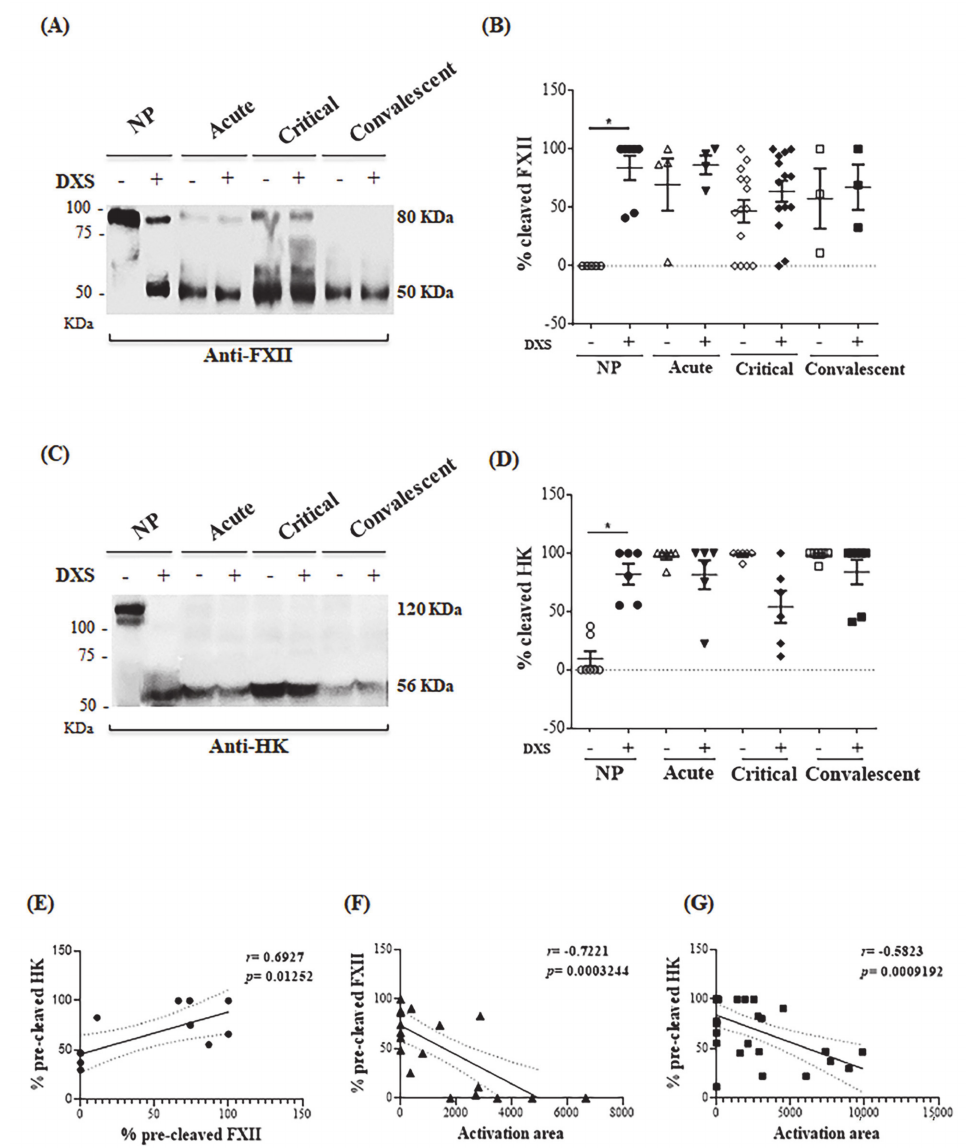
Figure 7. Evidence of early consumption of FXII and HK in the plasmas obtained from DENV-positive patients. NP or DP, at different stages of infection, were incubated or not with DXS for 1 h, at 37 ◦ C. The presence of FXII and HK were evaluated by western blotting. The bands corresponding to intact and cleaved proteins were measured using ImageJ software and the percentage of cleaved proteins was calculated. ( A ) Representative western blotting of FXII levels in plasmas collected from a single patient, at different time points of infection; ( B ) Individual plots of the percentage of cleaved FXII from plasmas incubated or not with DXS; ( C ) Representative western blotting of HK levels in plasmas collected from a single patient, at different time points of infection. ( D ) Individual plots of the percentage of cleaved HK from plasmas. * indicates p ≤ 0.05. ( E ) Correlation graph and calculation between the frequency of cleaved FXII and cleaved HK, in the absence of DXS (pre-cleaved), as measured by western blotting. ( F ) Correlation graph and calculation between PKa activation, as measured by the hydrolysis assay (activation area) with the frequency of cleaved FXII, in the absence of DXS (%pre-cleaved FXII), measured by western blotting; ( G ) Correlation graph and calculation between PKa activation, as measured by the hydrolysis assay (activation area) with the frequency of cleaved HK, in the absence of DXS (%pre-cleaved HK), measured by western